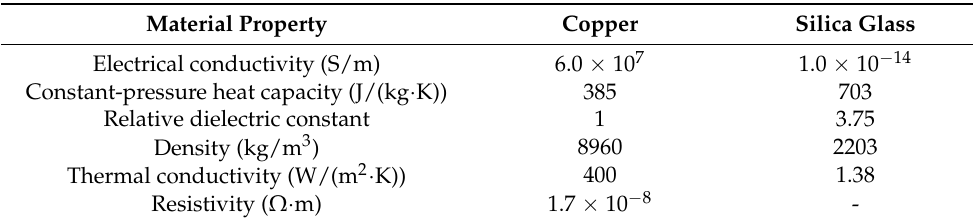
Table 1. Material